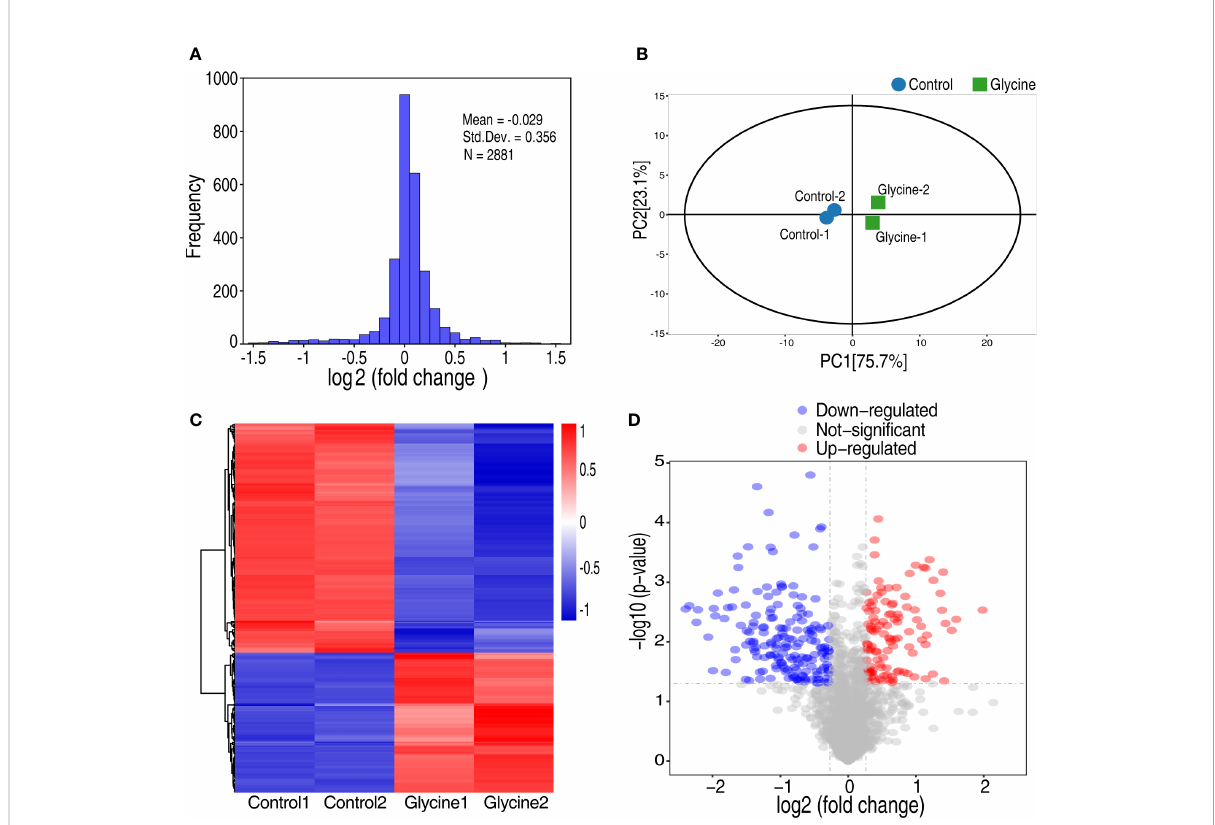
FIGURE 2 Analysis of glycine on the proteomics of Vibrio alginolyticus. (A) Frequency distribution of protein ratios (log 2 scale, glycine vs. control). (B) Principal component analysis between glycine and control. Each dot represents the technique replicas in the plot. (C) Hierarchical cluster analysis of 291 proteins expressed with statistically signi fi cant differences ( p < 0.05; fold change >1.2 or <0.83) in glycine-treated and untreated (control) samples. (D) Volcano plot of the P -values vs. the log 2 protein abundance differences between glycine-treated and control samples. Colors: red, upregulation; blue, down-regulation; gray, non-signi fi cant